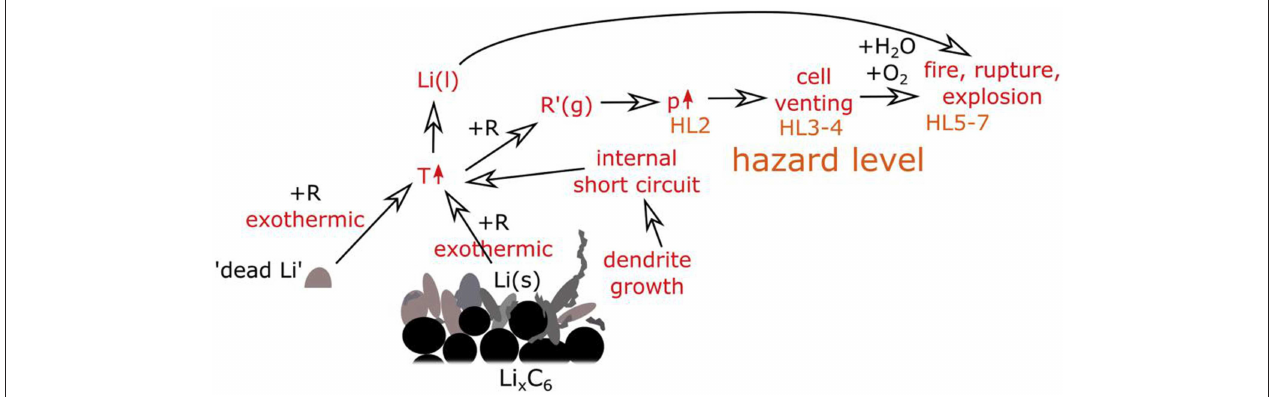
FIGURE 10 | General overview effect of plated Li on the safety for LIBs. Reprinted from Waldmann et al. (2018). Copyright (2018), with permission from